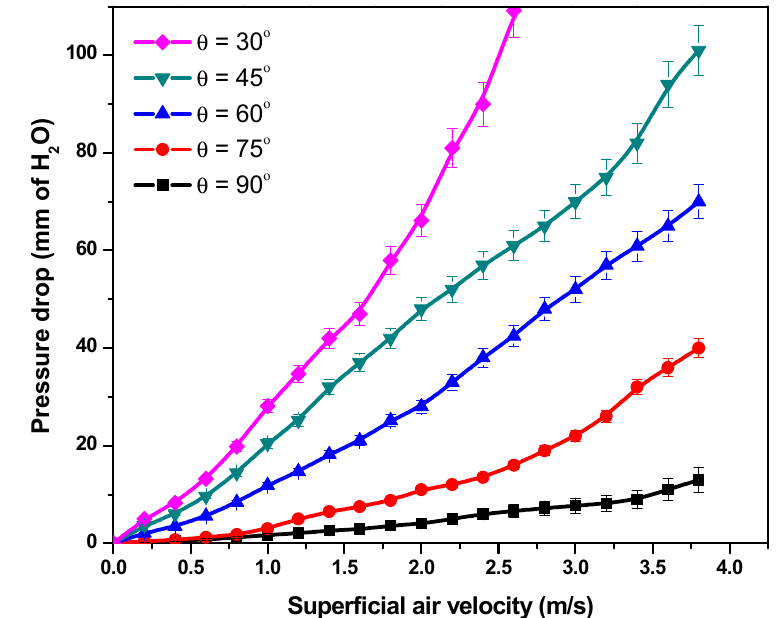
ff erent inclination